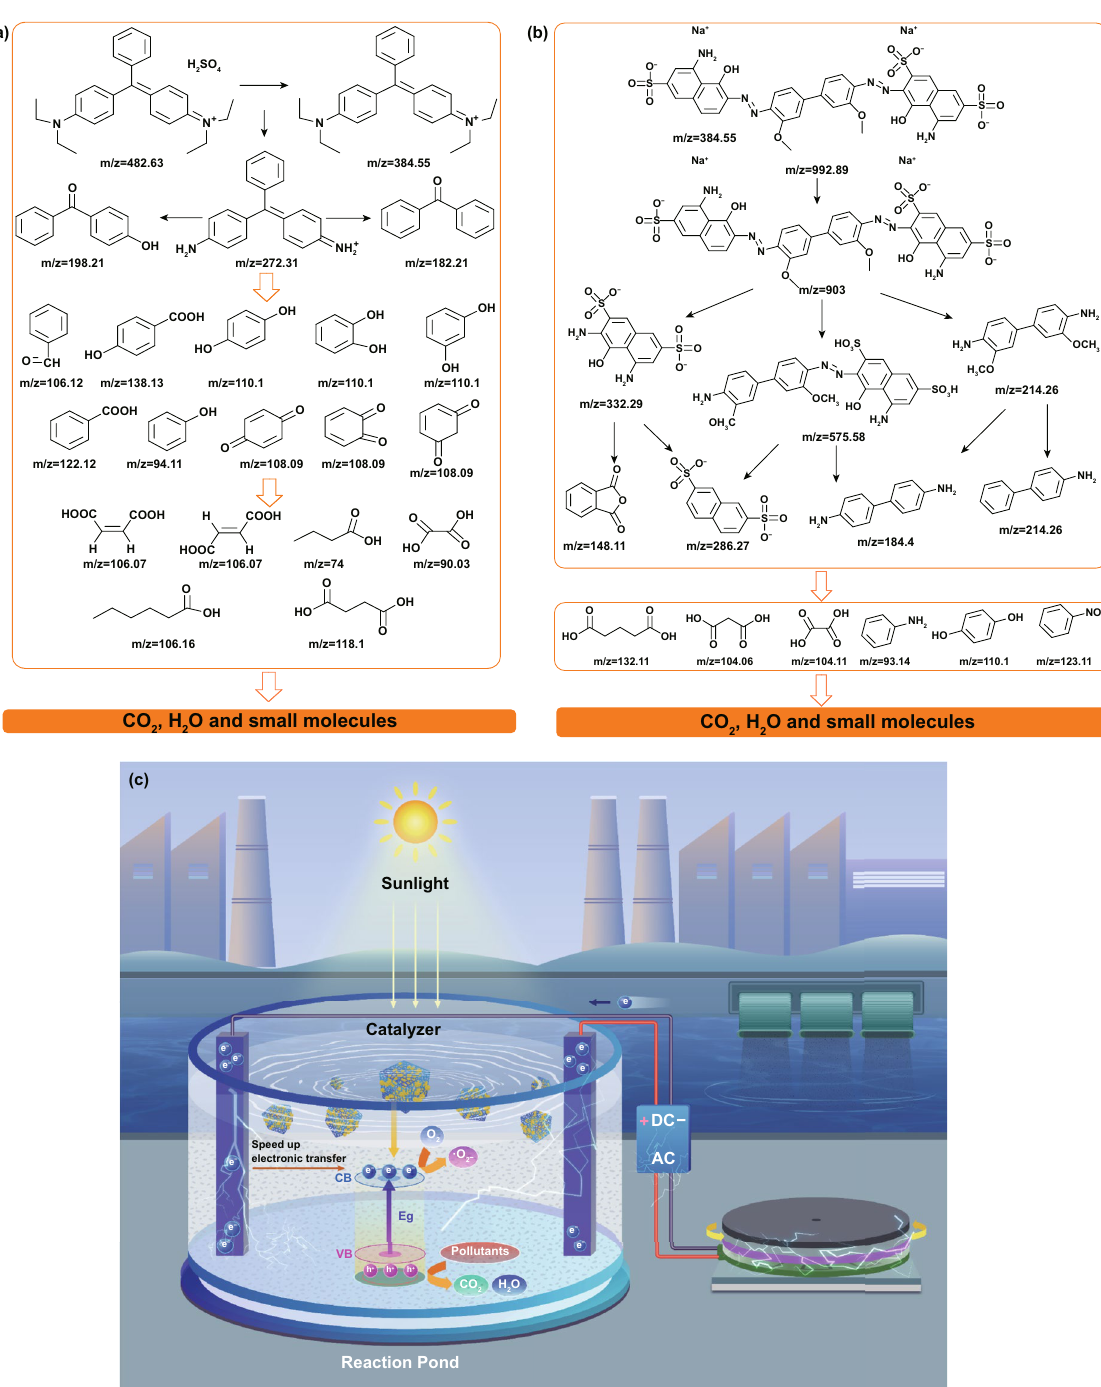
Fig. 6 Possible pathways for the degradation of a BG and b DB over TENG/3DGA@CDs-TNs photocatalysts under visible light irradiation. c Schematic showing the degradation mechanism of